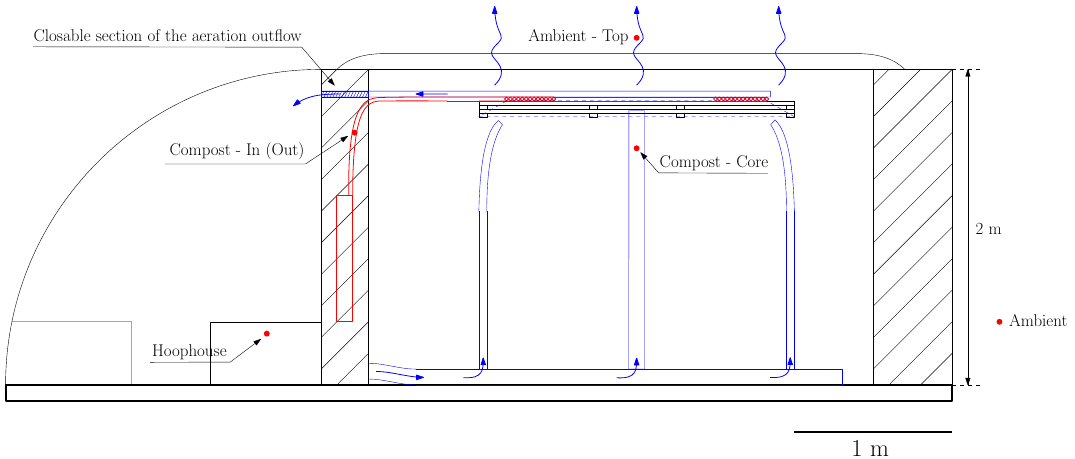
Figure 7. Side view of the composting